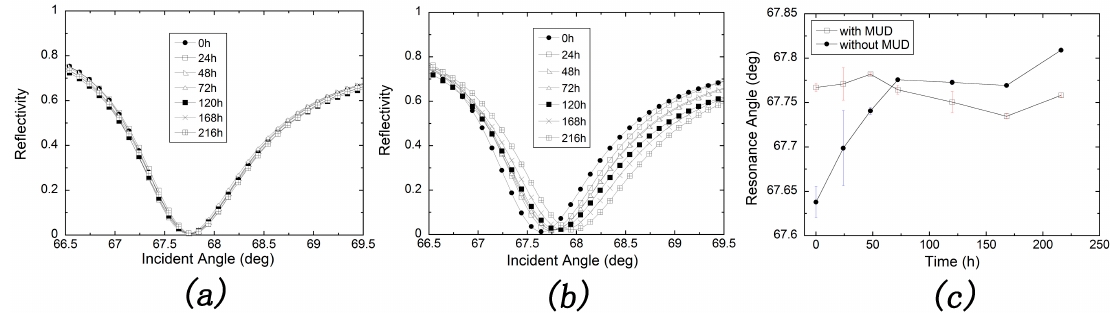
Figure 4. Long-term stability tests of silver-based SPR in ambient environment with ( a ) or without ( b ) protection of MUD SAM layer; ( c ) Resonance angle change with storage time calculated from ( a , b ). Error bars represent the standard deviations of three experiments.